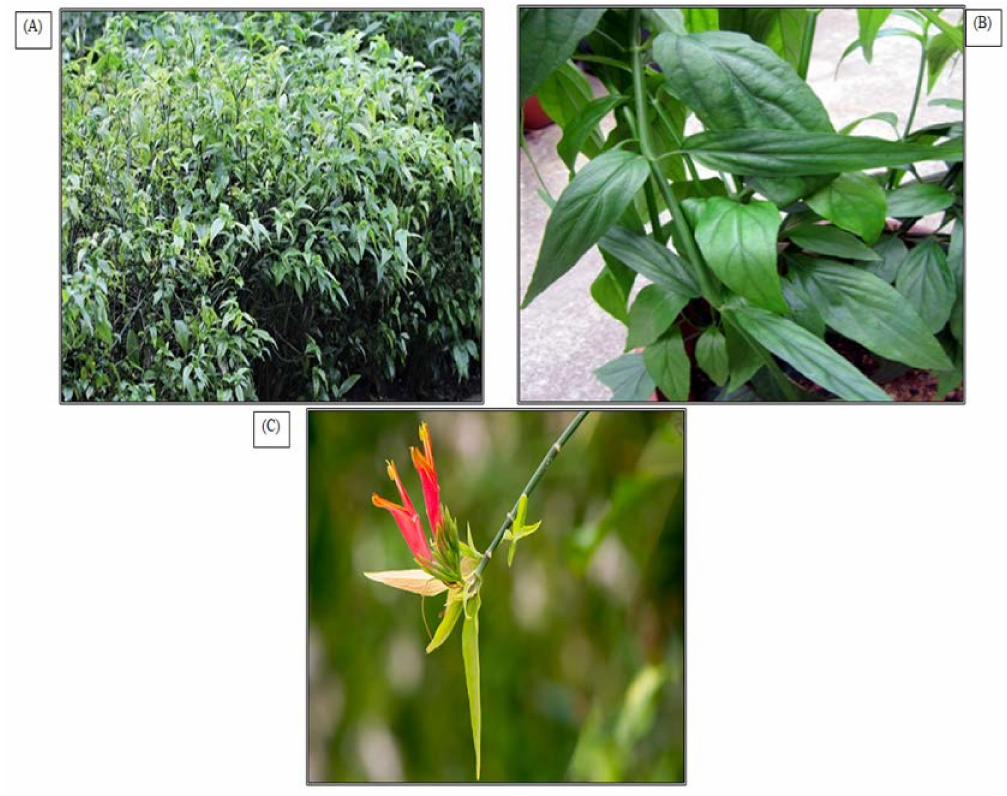
Figure 1. C. nutans in ( A ) plant habitat, ( B ) stems and leaves and ( C ) inflorescence (photographs of the plants were taken directly by using Canon, model number 3611C011, Tokyo,